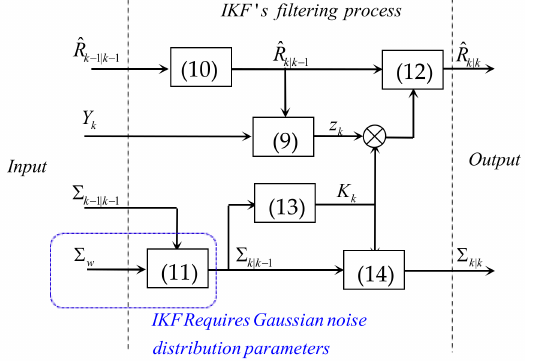
Figure 4. The filtering diagram of the invariant Kalman filter for attitude